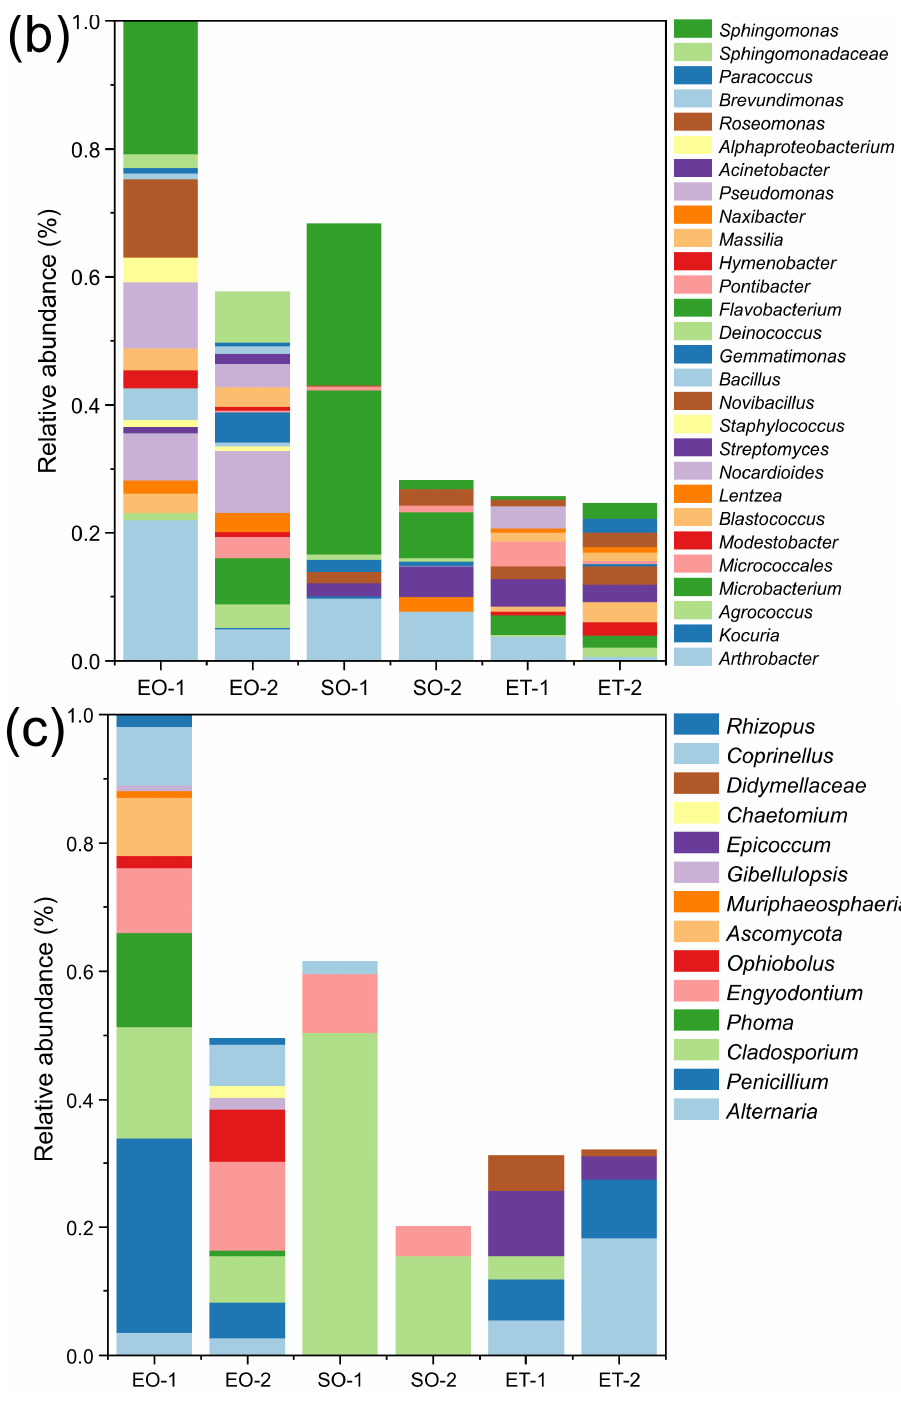
Figure 5. Relative abundance of the culturable bacteria at the phylum level ( a ) and genus level ( b ) and the culturable fungi at the genus level ( c ).